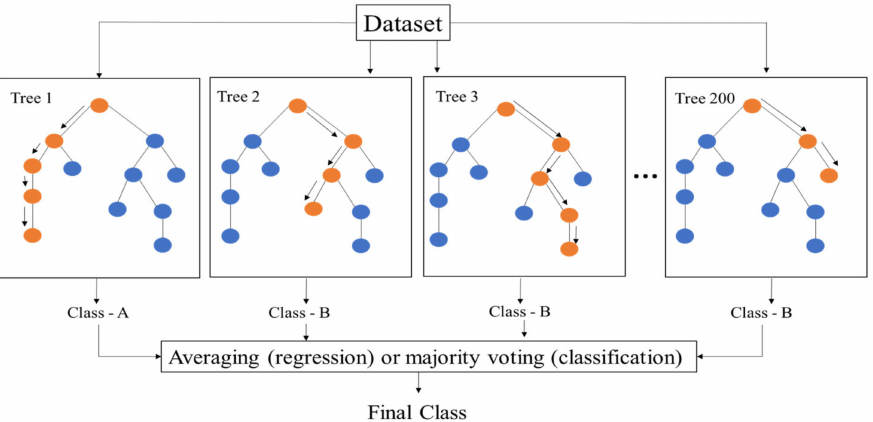
Figure 4. The architecture of the proposed RF